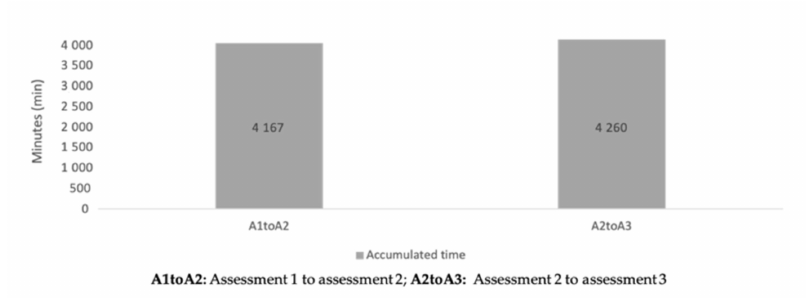
Figure 7. Accumulated time during the periods of the